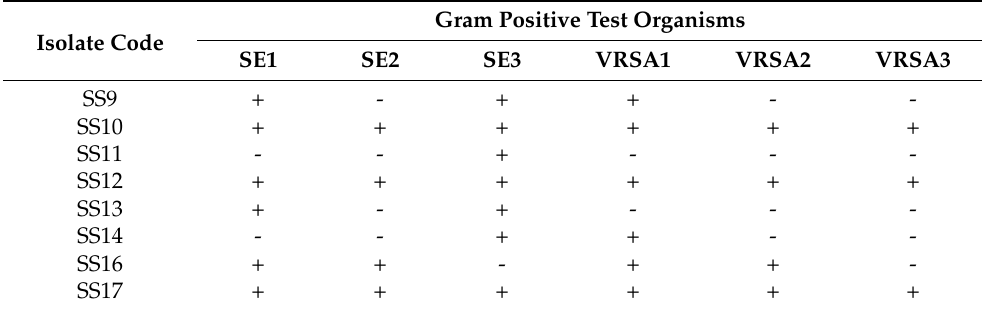
Table 1. Preliminary screening against Gram positive test organisms.